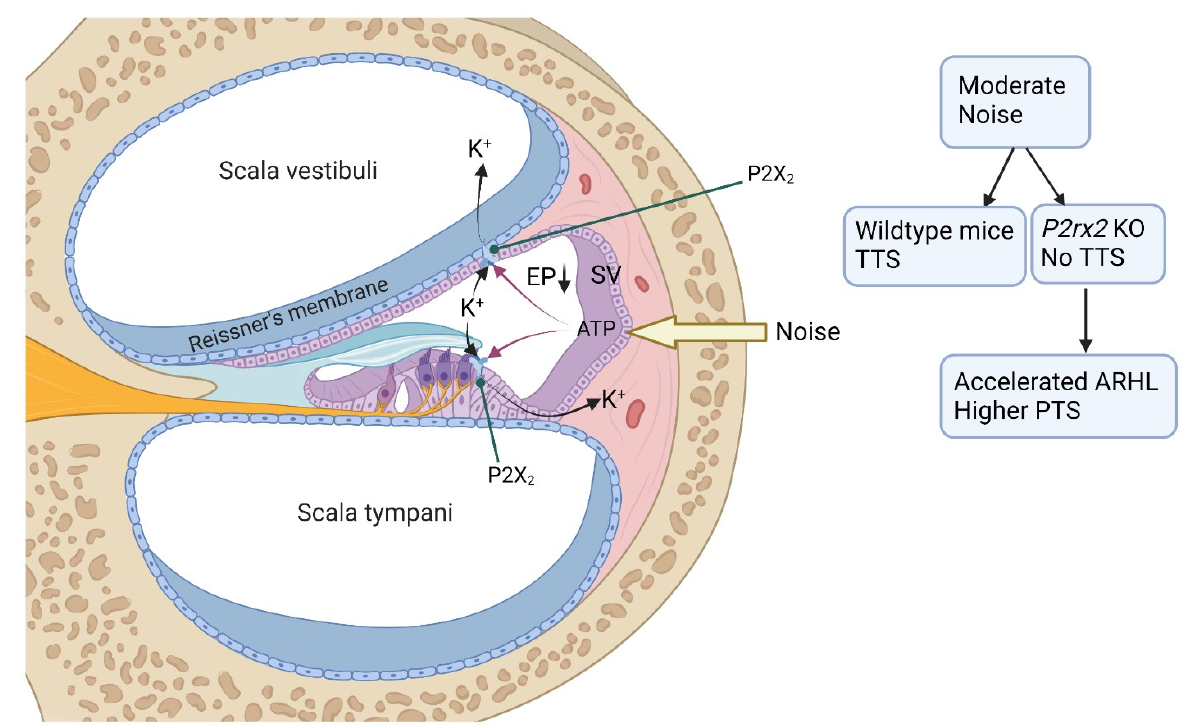
Figure 3. Purinergic hearing adaptation. Exposure to moderate noise levels induces ATP release from the stria vascularis (SV). ATP activates P2X 2 receptors in the tissues lining the endolympatic compartment (e.g., Reissner’s membrane, sensory and supporting cells). The activation of P2X 2 receptors mediates K + shunt conductance from scala media, thus reducing the endocochlear potential (EP), the driving force for sensory transduction. Reduced EP results in decreased sensitivity of the cochlea to sound stimulation, protecting the ear from permanent damage and hearing loss. The role of P2X 2 receptors in hearing adaptation was demonstrated using P2rx2 knockout (KO) mice. Exposure to moderate noise levels caused temporary threshold shift (TTS) in wildtype mice but not in P2rx2 KO mice. Without purinergic hearing adaptation, P2rx2 KO mice showed accelerated age-related hearing loss (ARHL) and elevated permanent threshold shift (PTS) in response to higher noise levels. Created with BioRender.com.